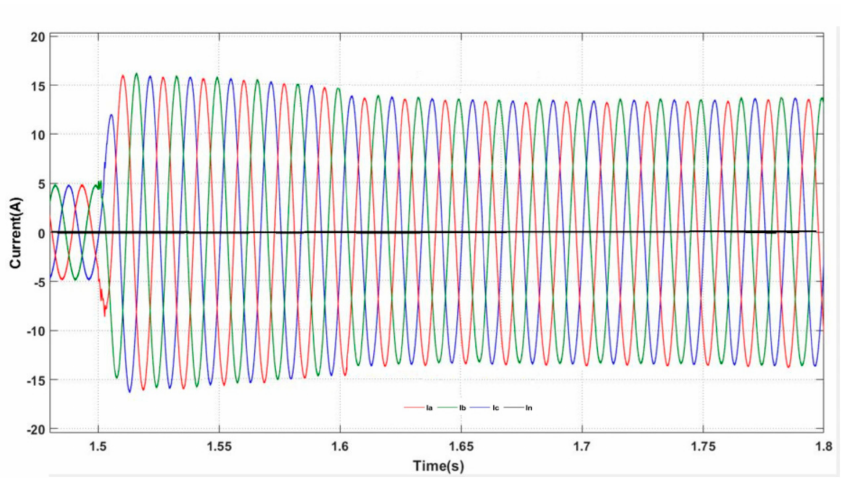
Figure 25. Experimental result of the RNN for case 4.